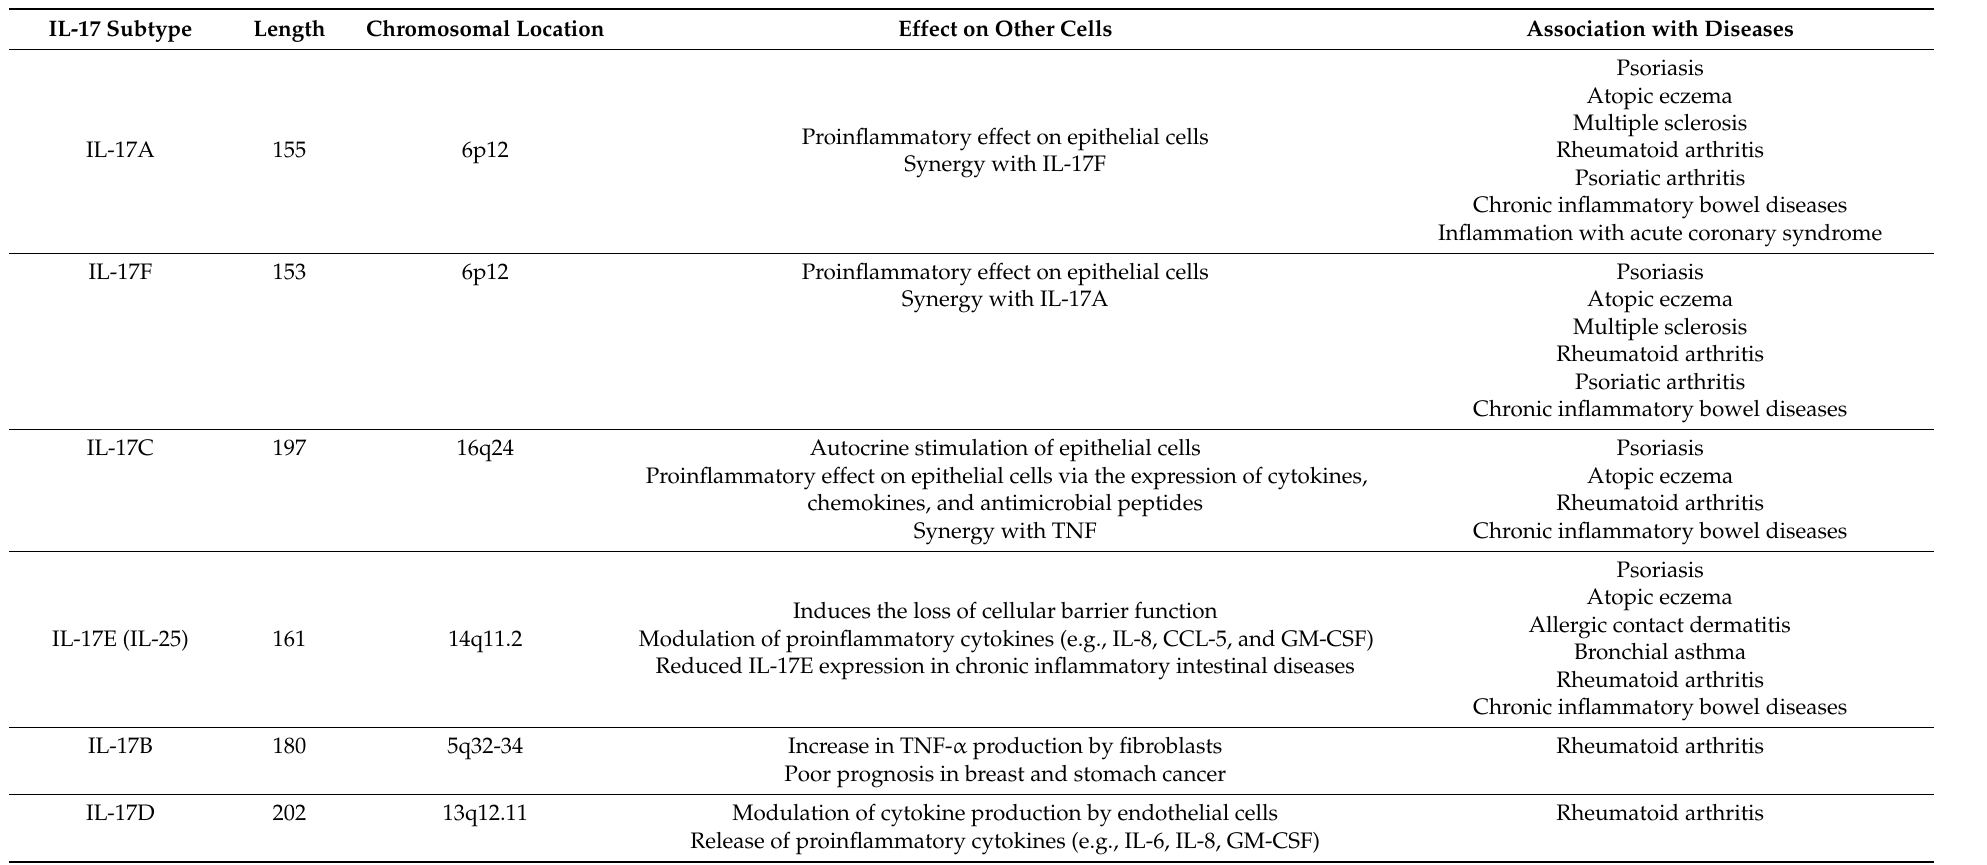
Table 1. Overview of IL-17 subtypes with characteristic length, encoding genes, effect on other cells, and association with